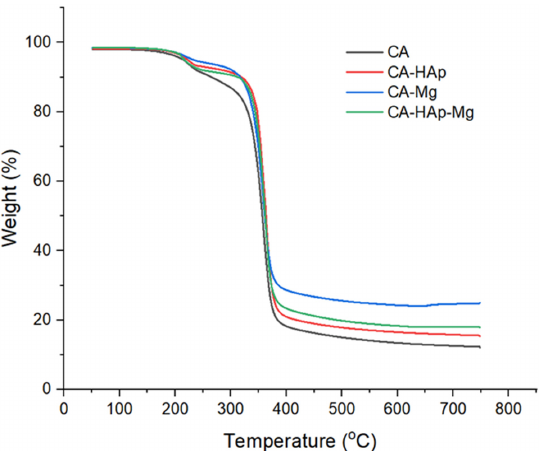
Figure 5. TGA curve of the experimental samples (CA, CA-HAp, CA-Mg, and CA-HAp-Mg).